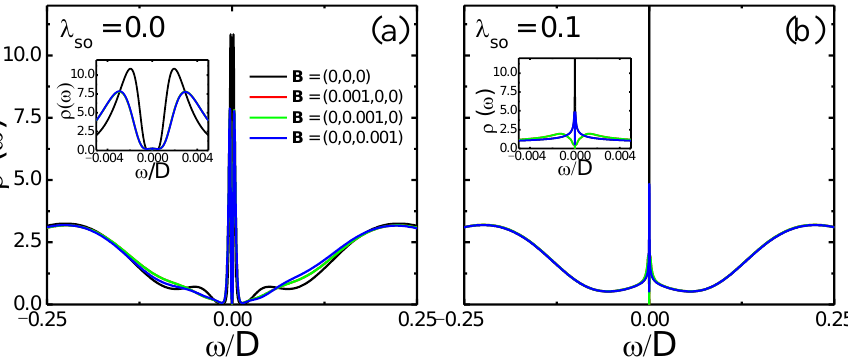
Figure 5. Impurity density of states, ρ ( ω ) = ρ ↑ ( ω ) + ρ ↓ ( ω ) , for energies around the Fermi energy ( ω = 0). ( a ) Results for vanishing magnetic field (black curve) and for | B | = 0.001 along the three coordinate axes (see legend), with λ SO = 0.0. ( b ) Same magnetic field values as in panel ( a ), but for λ SO = 0.1. The insets show zooms of the Kondo